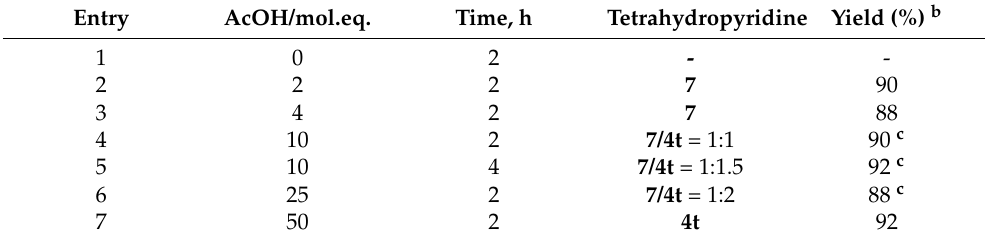
Table 3. Dehydration of 6d a .